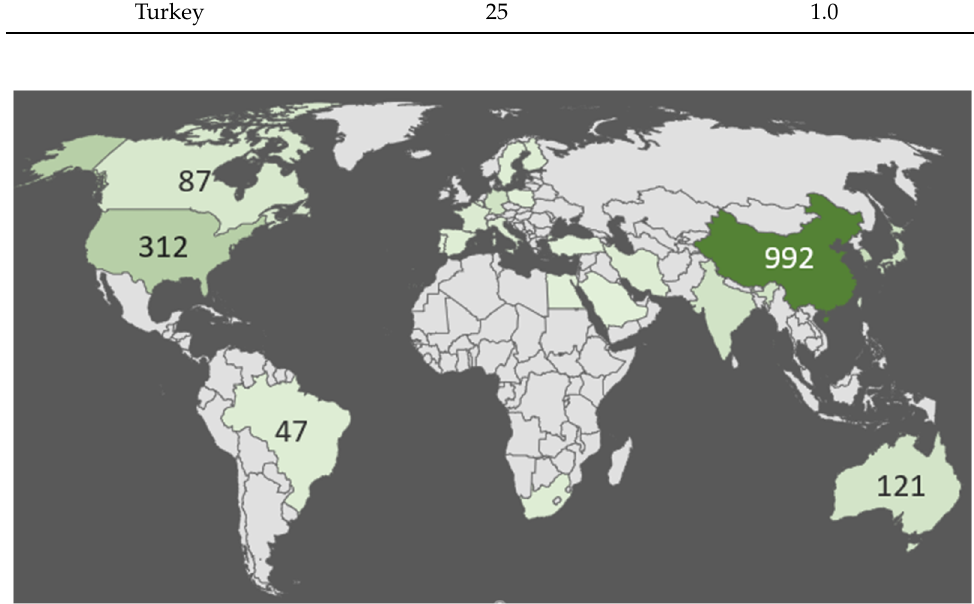
Figure 6. Publication per year–demographic distribution with the number of publications in the LIB recycling field.